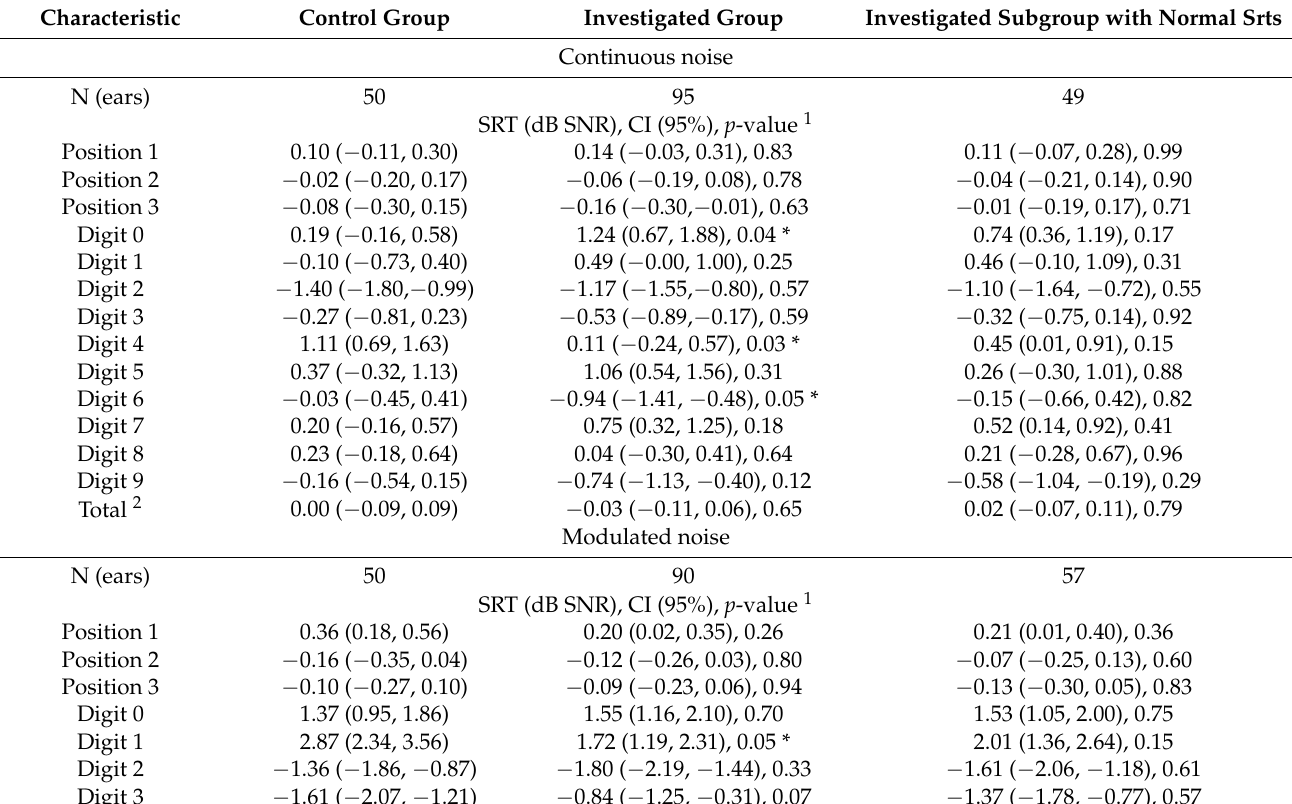
Table A1. Position-specific and digit-specific speech reception threshold